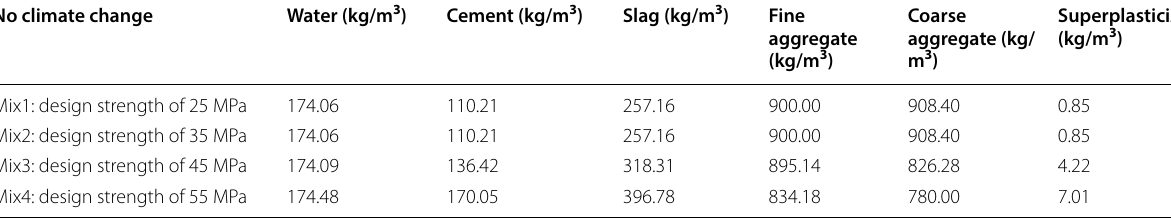
Table 5 Mixtures of concrete under a no climate change scenario.